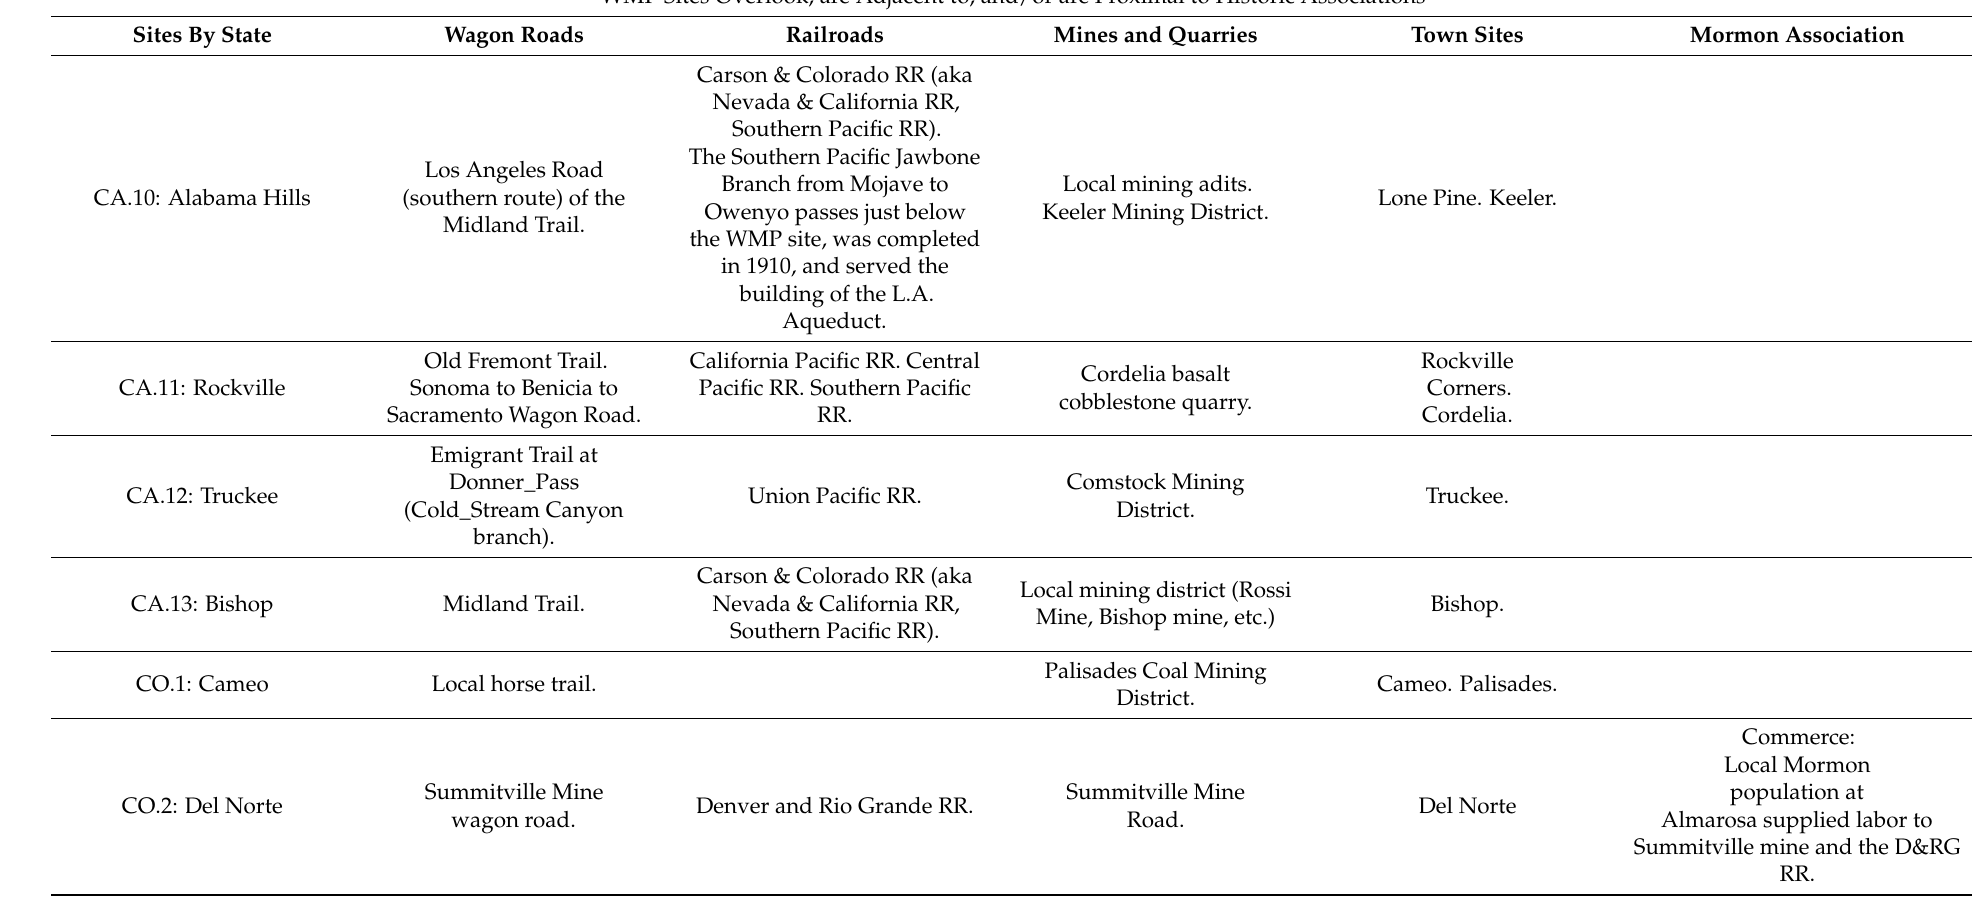
Table A2. Cont. WMP Sites Overlook, are Adjacent to, and/or are Proximal to Historic